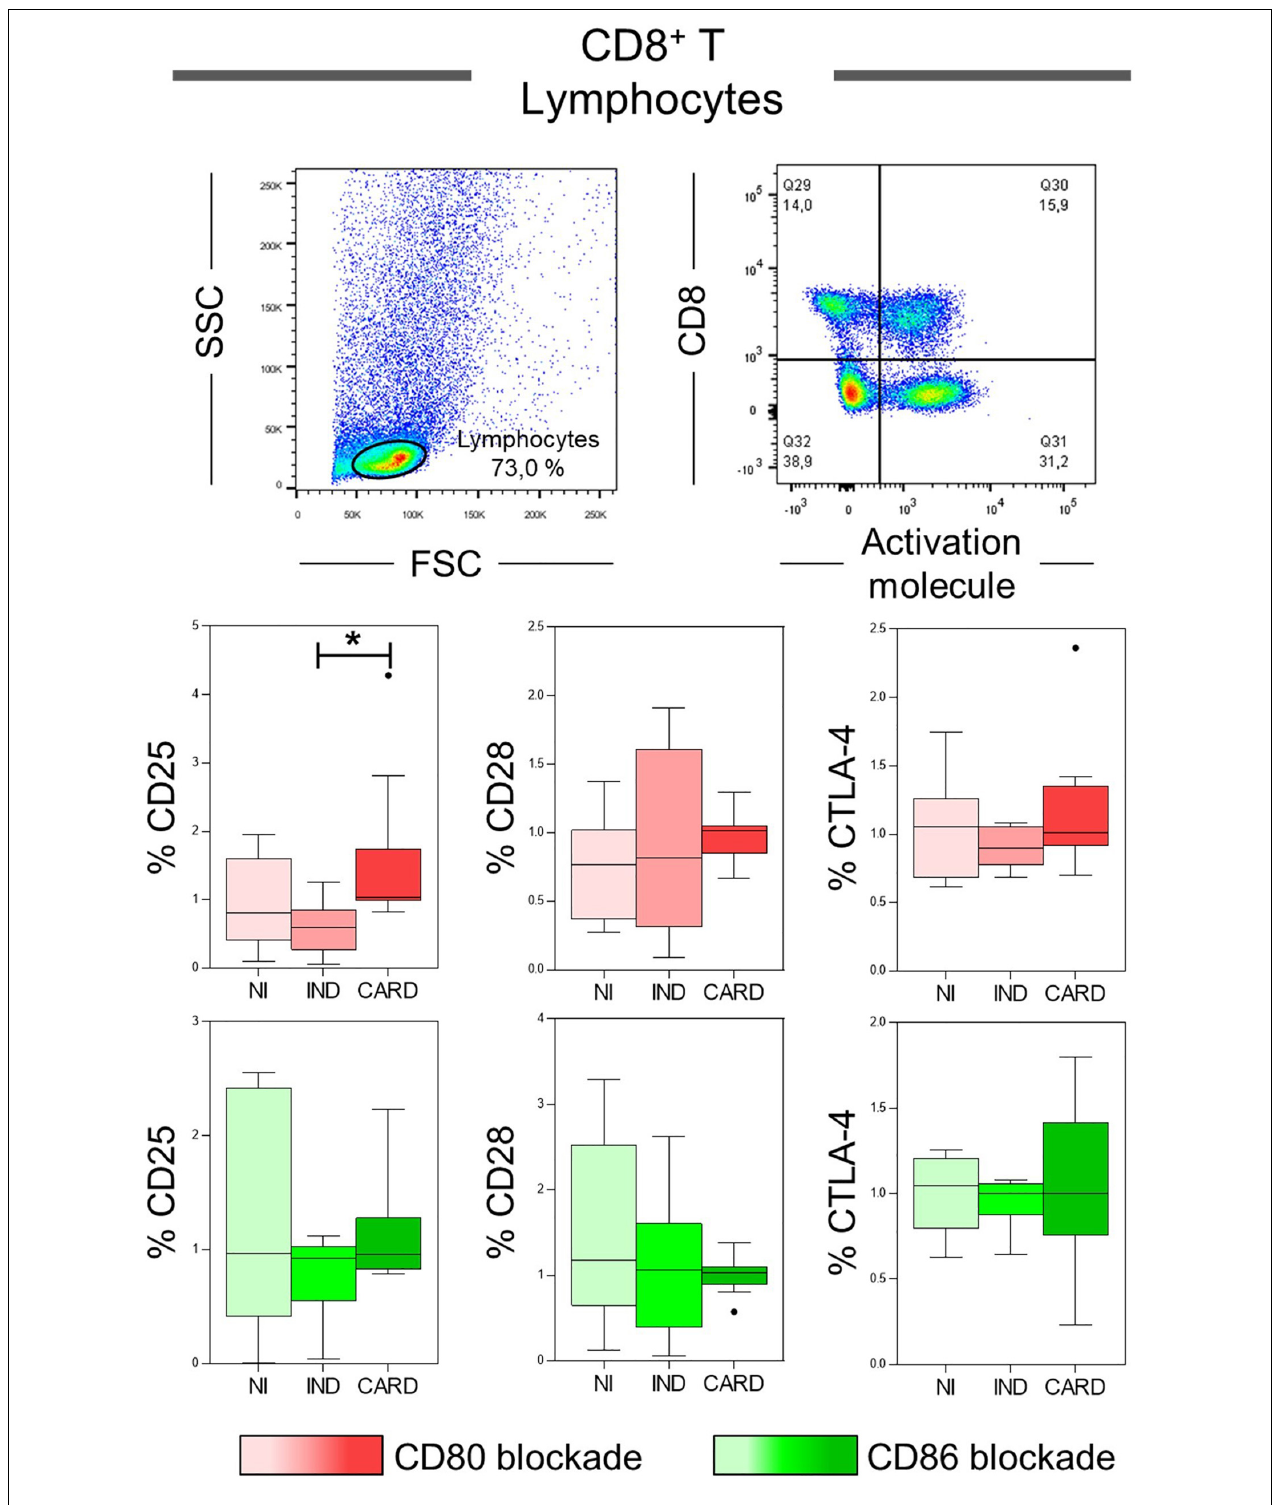
FIGURE 3 | Analysis of the phenotypic-functional profile of CD8 + T lymphocytes after anti-CD80 and anti-CD86 antibody blockade. Flow cytometry gate strategy of non-infected (NI) individuals is represented. Frequency of T CD8 + lymphocytes expressing CD25, CD28, and CTLA-4 activations molecules in PBMC culture from NI individuals ( n = 9), indeterminate (IND, n = 9), and cardiac (CARD, n = 11) clinical forms of Chagas disease, after in vitro stimulation with T. cruzi antigens and anti-CD80 and anti-CD86 antibody blockade. Statistical differences ( p < 0.05) between groups were obtained by Kruskal-Wallis test, followed by Dunn’s post-test, and represented by asterisk (*) and lines. Boxes demonstrate the median and interquartile ranges, whiskers evidence the highest and lowest observation, and dots represent the outliers.